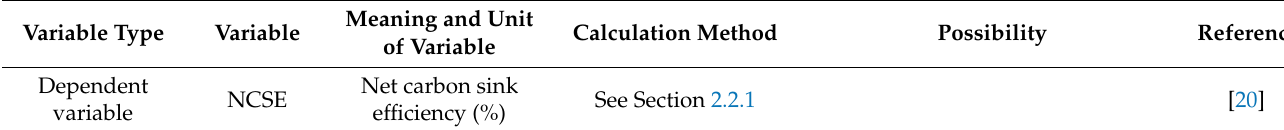
Table 3. The introduction of the